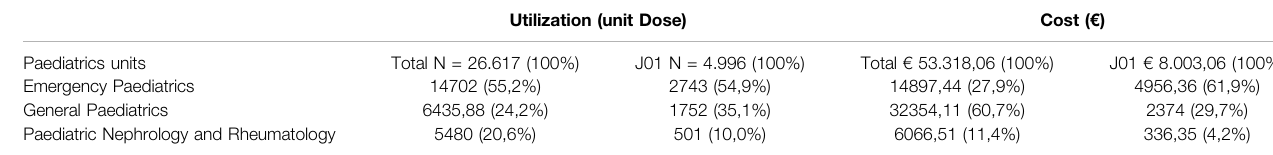
Utilization (unit Dose)